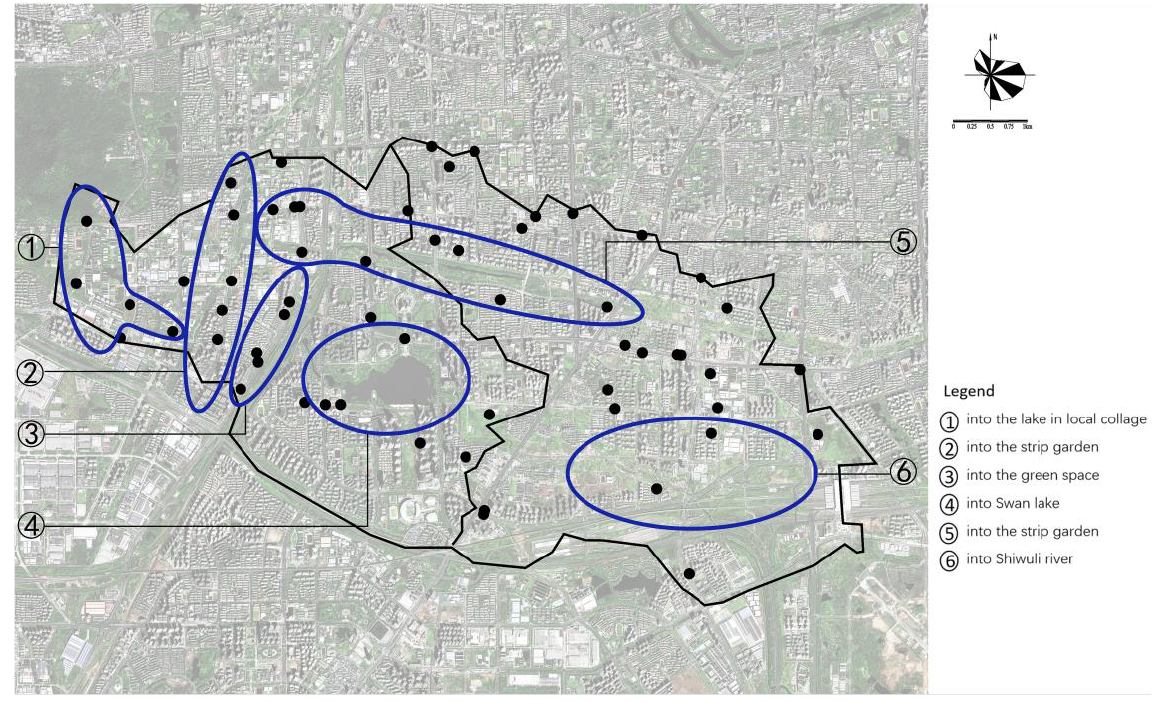
Figure 5. The region of blue-green transformation planning in the upper stream.